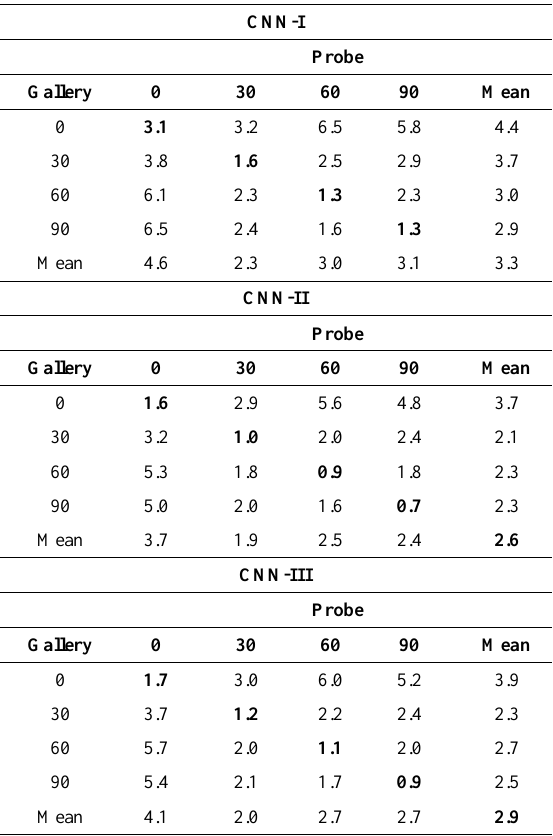
Table 4. Equal Error Rate OUISIR-LP dataset